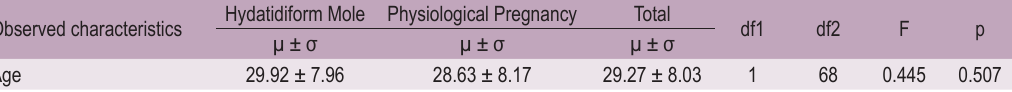
TABLE 1. Average pregnant woman’s age Observed characteristics